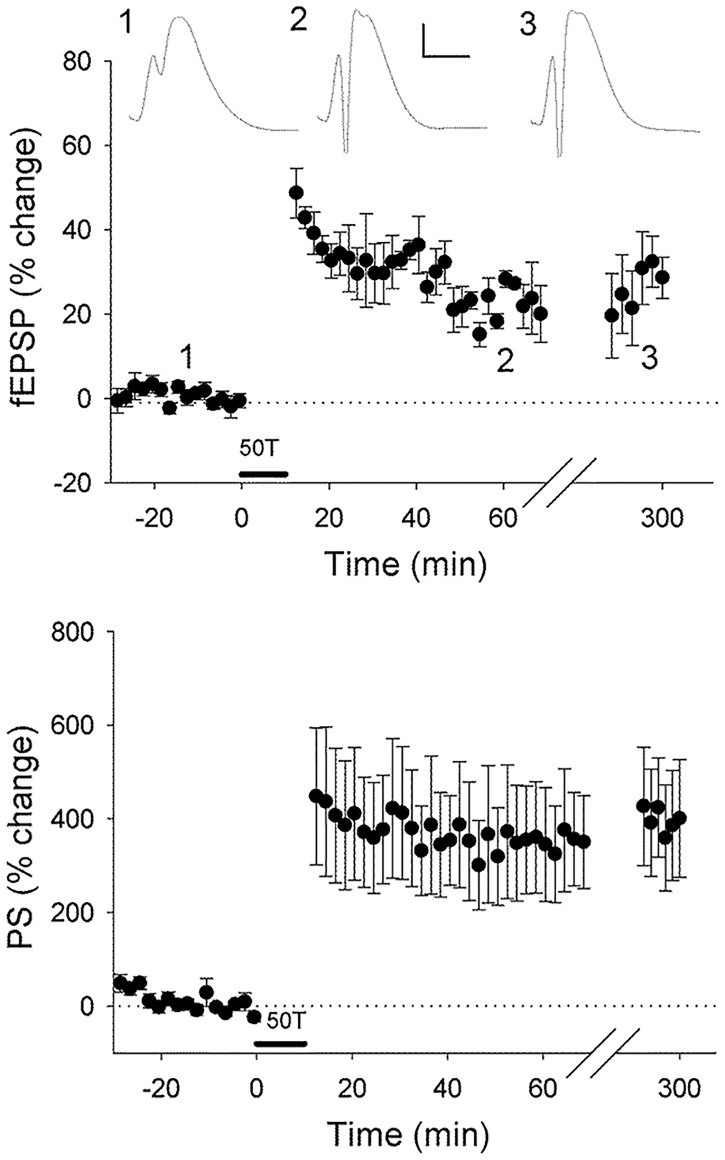
Induction of robust LTP at perforant path-granule cell synapses in awake adult rats.Average (± SEM) field excitatory postsynaptic potential (fEPSP) and population spike (PS) responses expressed as percentage of baseline values. Inset waveforms are averages of 10 sweeps taken just before tetanisation (1), 15–20 min after (2), and 5 h after (3). Calibration bars: 5 ms, 5 mV. 50T: tetanisation paradigm consisting of 50 trains of 400 Hz stimulation.